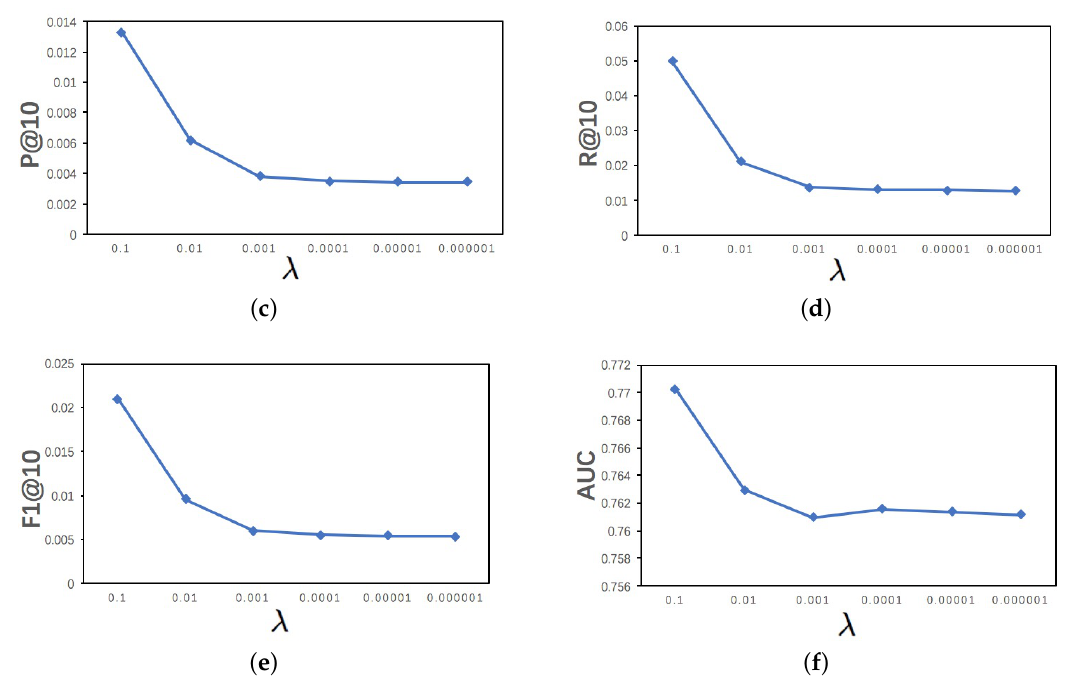
Figure 2. λ Analysis in Epinions DataSet: ( a ) effect on P@10 when varying the λ ; ( b ) effect on R@10 when varying the λ ; ( c ) effect on F1@10 when varying the λ ; and ( d ) effect on AUC when varying the λ